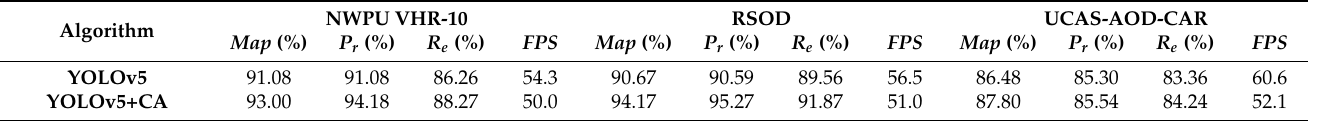
Table 3. Effects of Coordinate Attention module on three datasets.